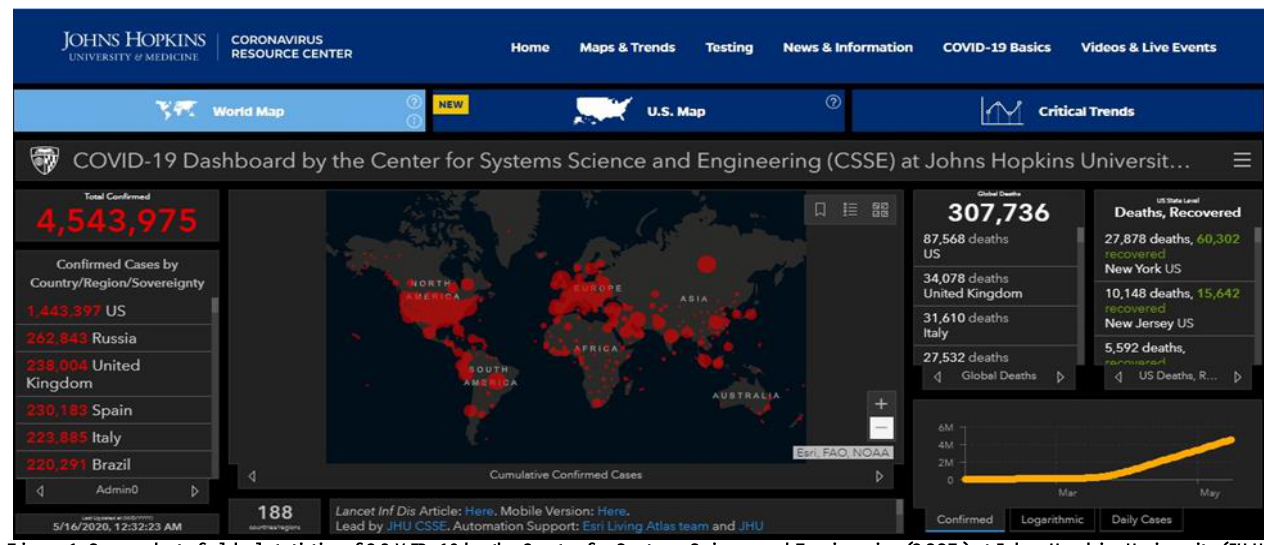
Figure 1. Screenshot of global statistics of COVID-19 by the Center for Systems Science and Engineering (CSSE) at Johns Hopkins University (JHU). Available at https://coronavirus.jhu.edu/map.html. Table1. Online Resources for COVID-19. Online